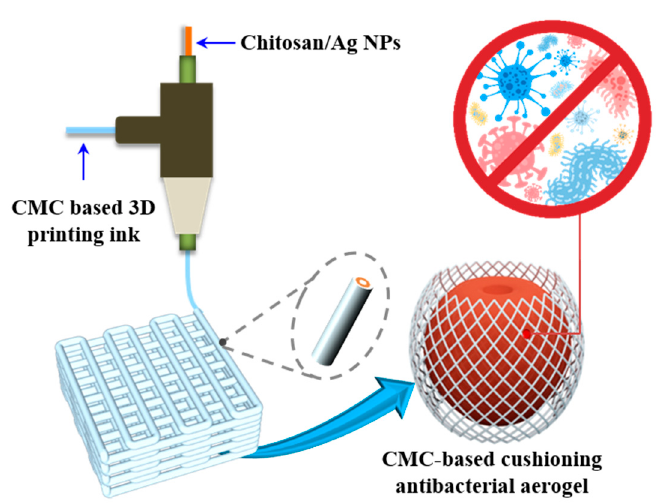
Figure 1. Scheme for the preparation process of 3D-printed carboxymethyl nanocellulose-based cushioning and antibacterial dual-function food packaging aerogels.